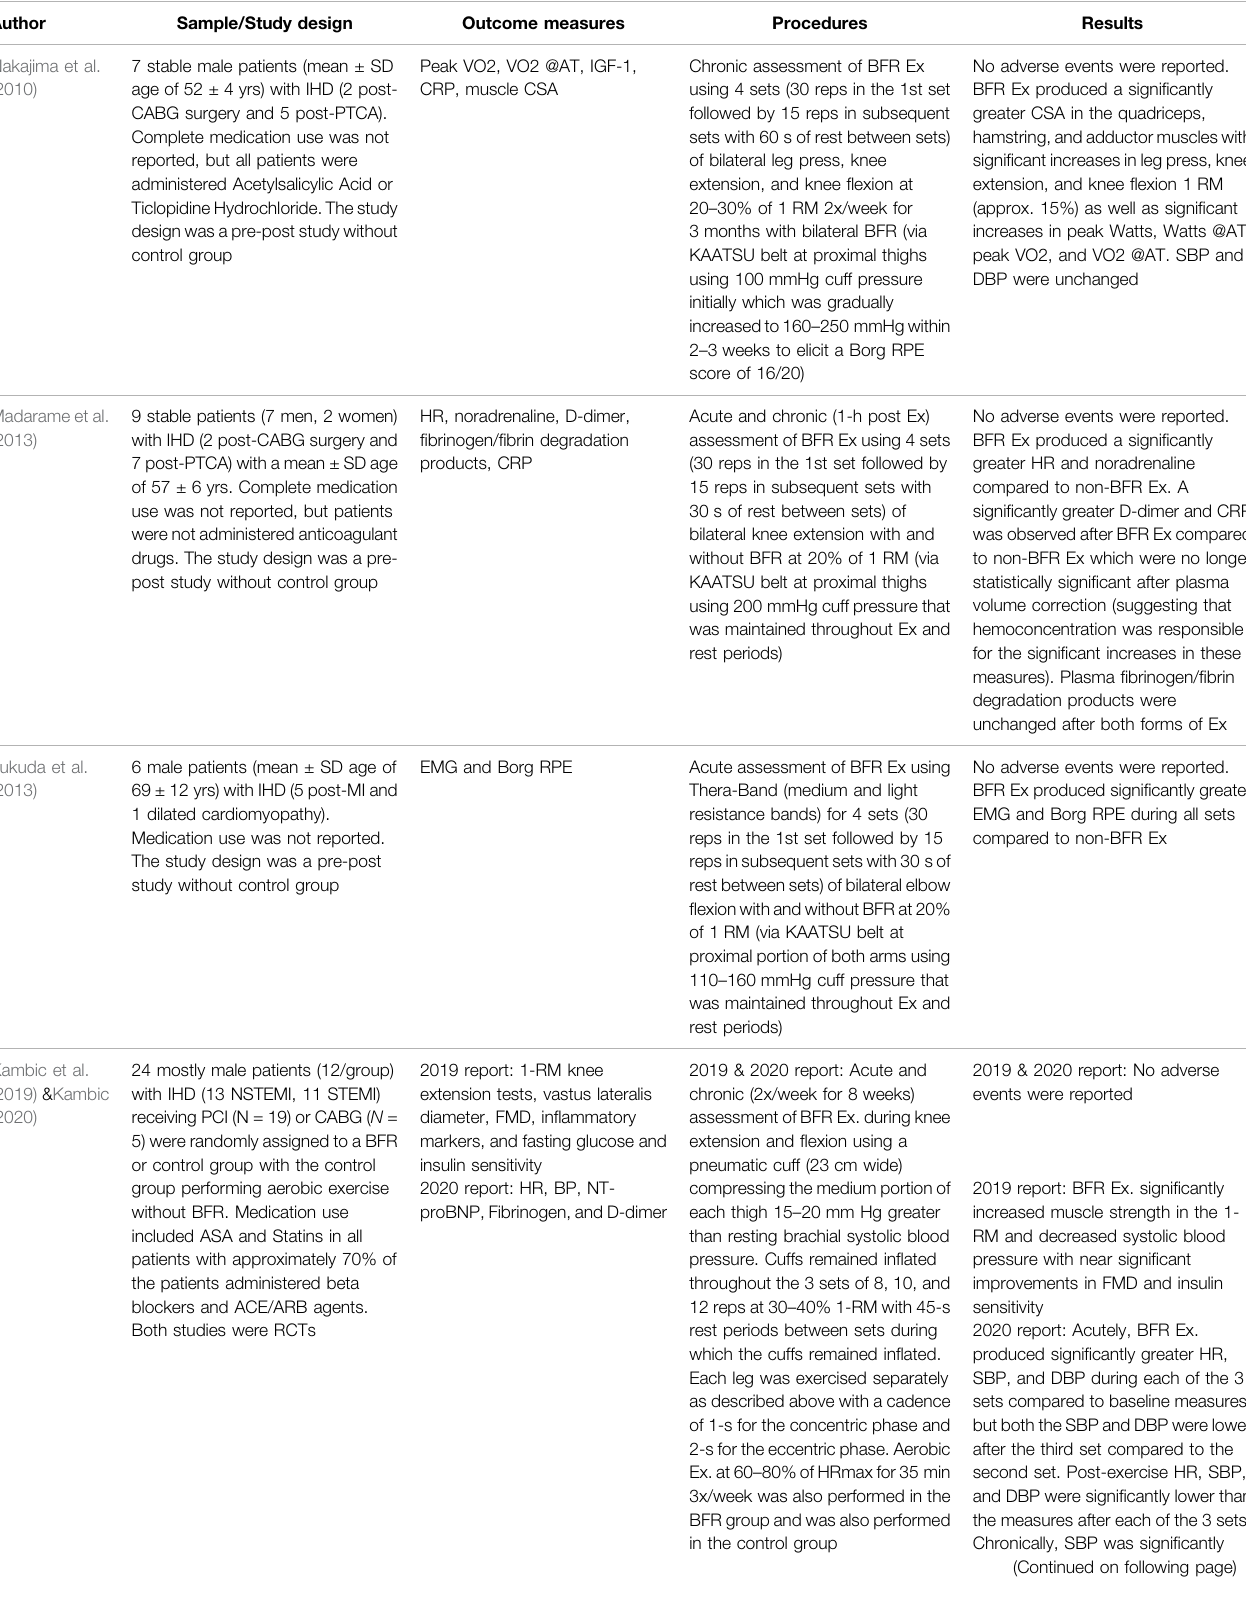
TABLE 4 | Studies of blood fl ow restriction training in patients with heart